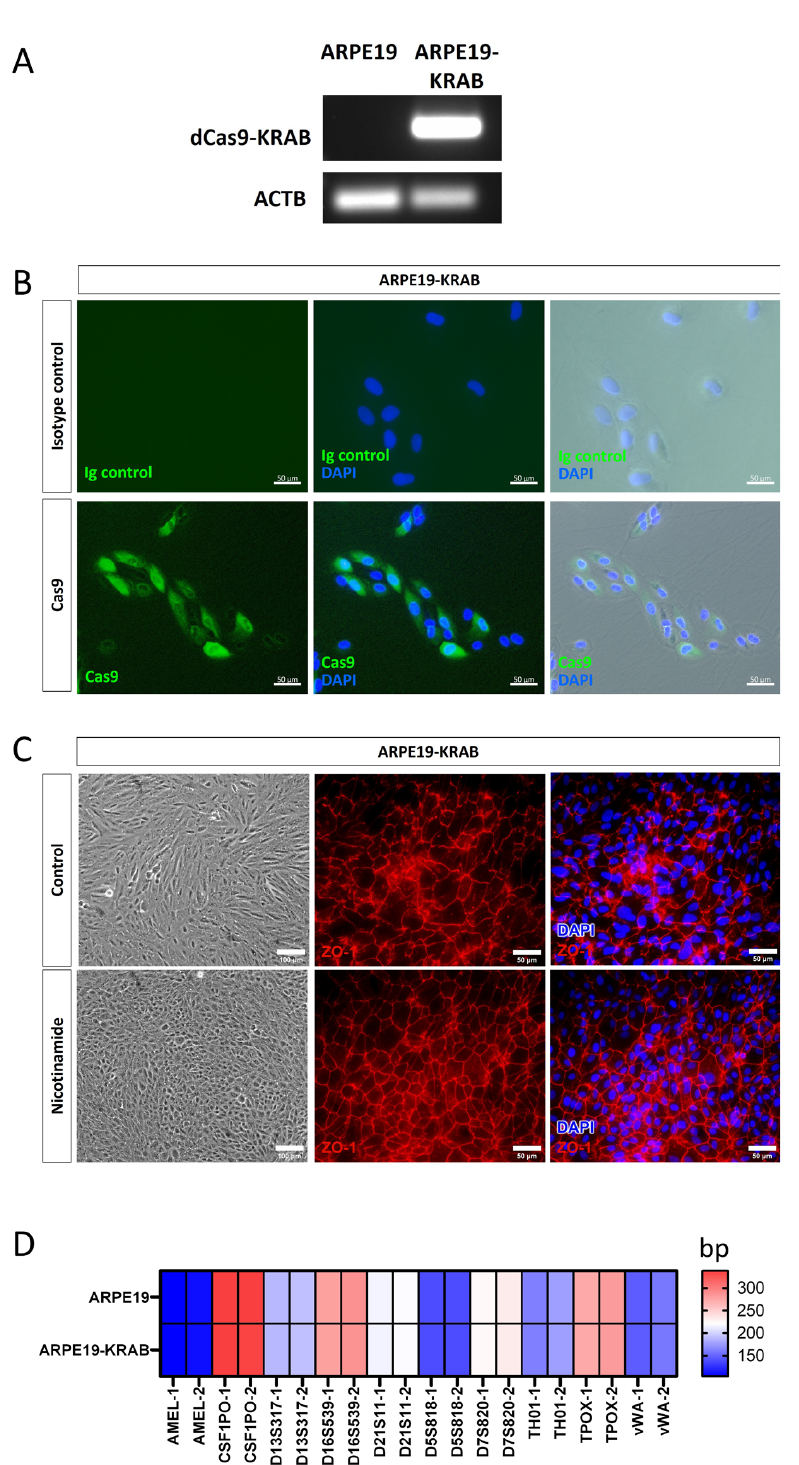
Figure 1. Generation of a stable CRISPRi human RPE cell line expressing dCas9-KRAB. Characterization of ARPE19-KRAB cell line showing expression of ( A ) KRAB by RT-PCR, and ( B ) SpCas9 by immunocytochemistry. ( C ) ARPE19-KRAB was able to form polarised monolayer upon nicotinamide treatment. Left panel shows representative morphology of ARPE19-KRAB treated with control condition (10% FCS) or differentiation media with nicotinamide. Middle and right panel show immunocytochemistry of tight junction protein ZO-1. ( D ) Heatmap of short tandem repeat analysis of 10 polymorphic markers. Alleles 1 and 2 are designated as − 1 and − 2